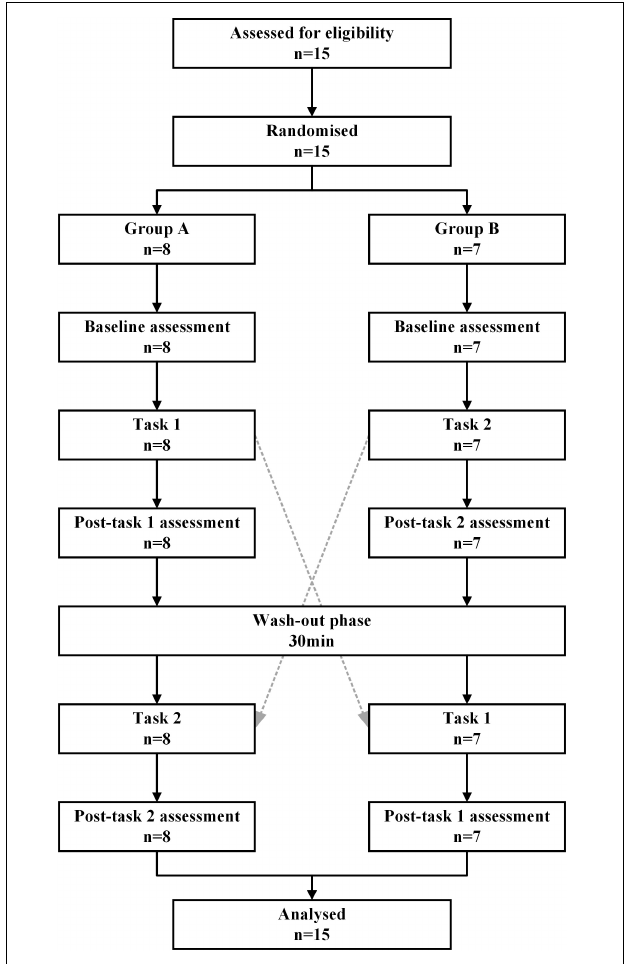
FIGURE 1 | Cross-over design of the study. Task 1: NIVR-Exergame task; Task 2: resistance band stretching task; Post-task 1: after the NIVR-Exergame task; Post-task 2: after the resistance band stretching task. min,